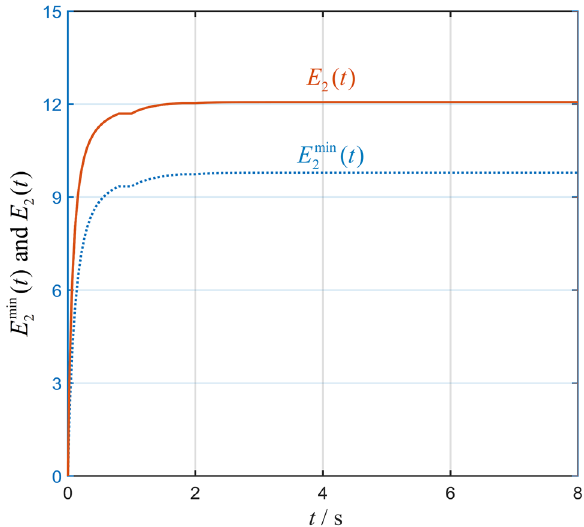
min t ) and E 2 ( t ) 2 (